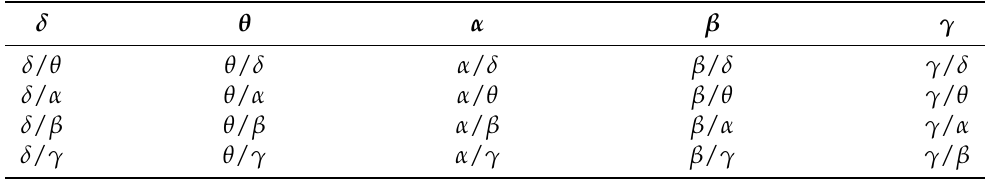
Table 1. Power ratios calculated for all frequency bands.